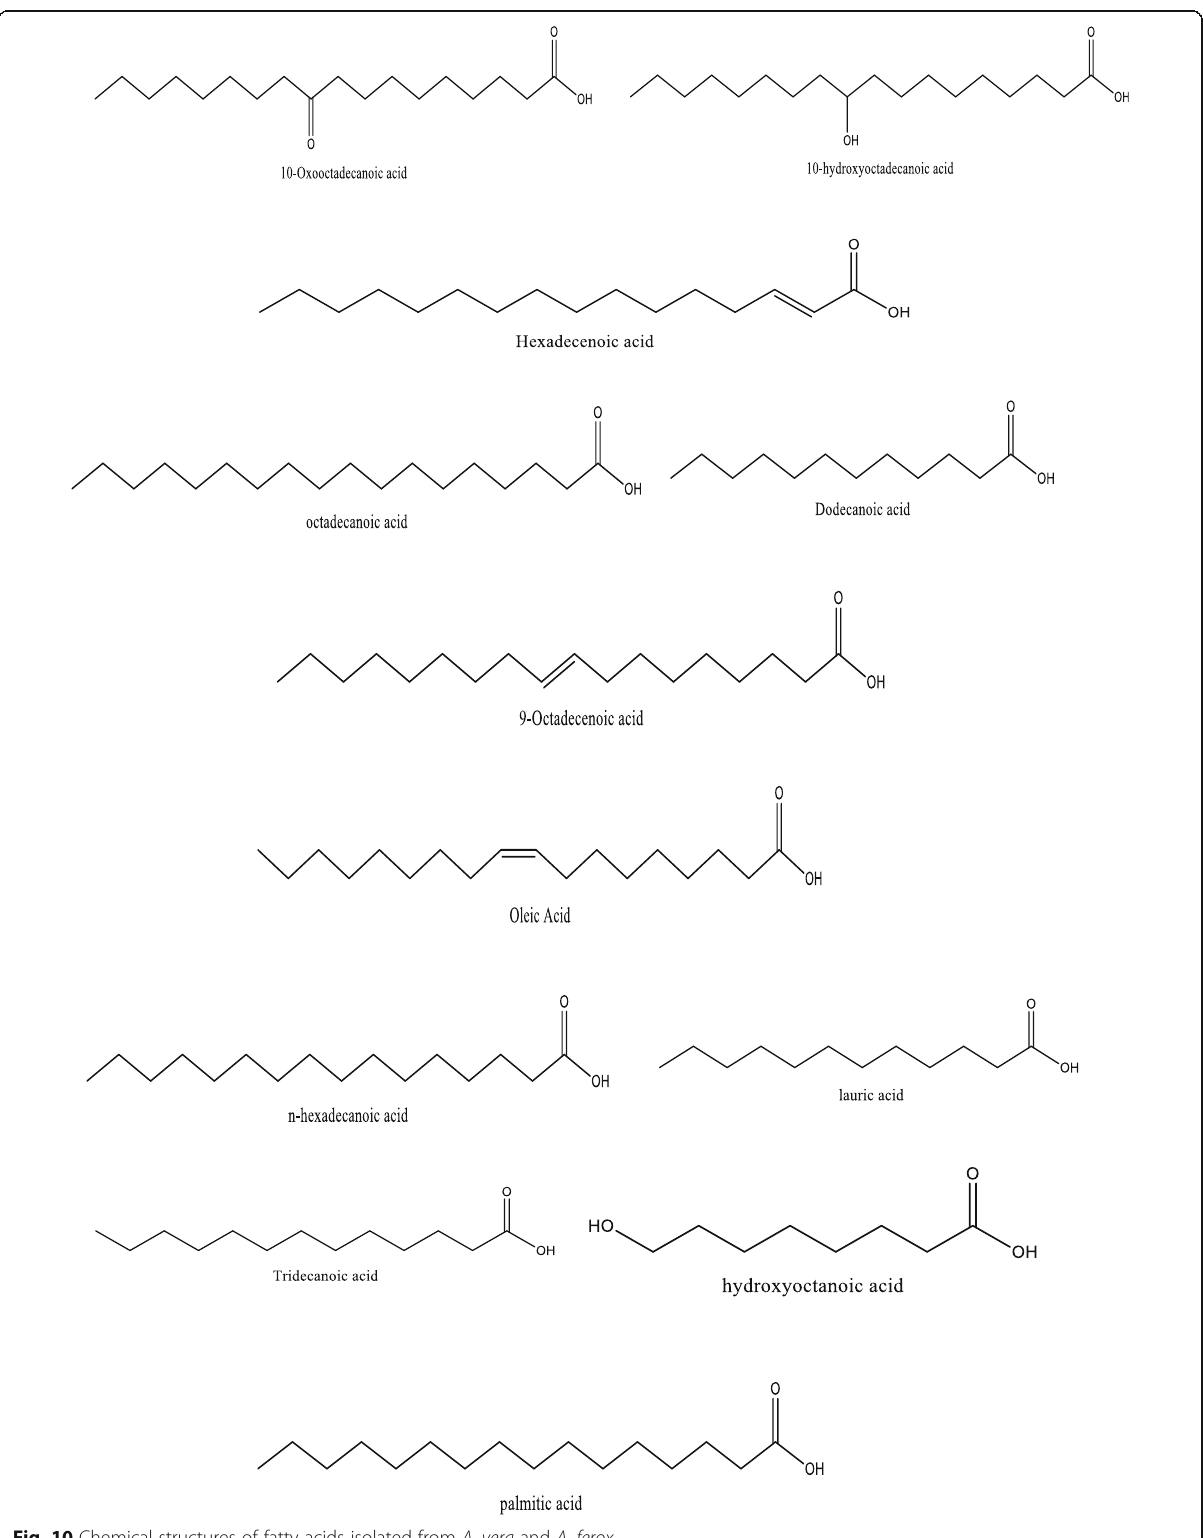
Fig. 10 Chemical structures of fatty acids isolated from A. vera and A.